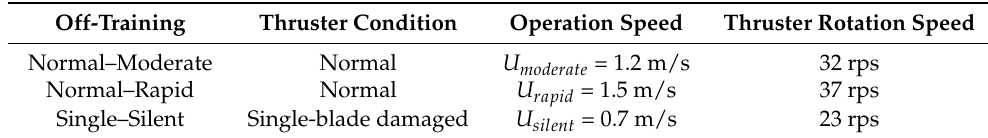
Table 7. Off-training test